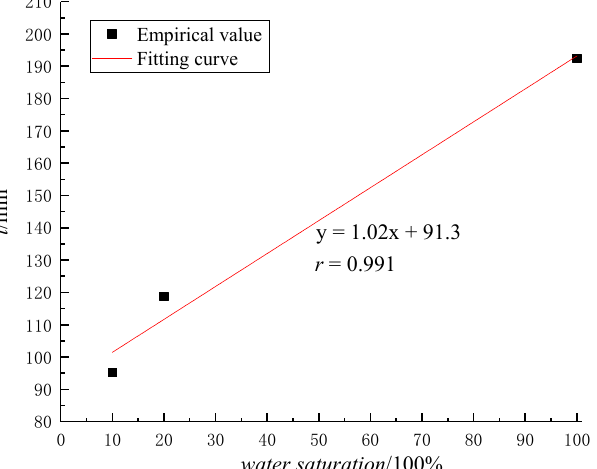
Figure 5. Relationship between different water saturation conditions and time taken for D4 temperature to drop to − 4 °C.